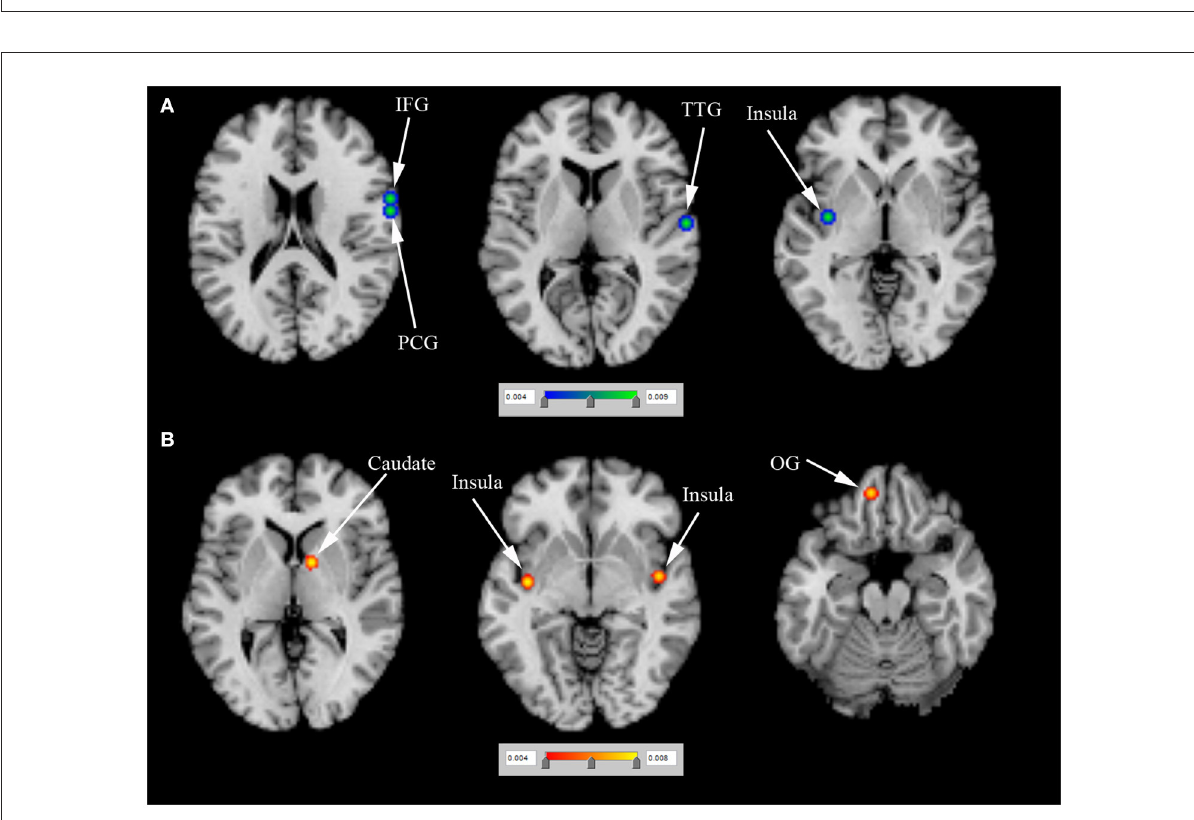
FIGURE3 (A) Reduced resting-state brain activation (in blue) and (B) increased resting-state brain activation (in red) in PD-ICD patients, compared to PD-no ICD. ICD, impulse control disorder; IFG, inferior frontal gyrus; OG, orbital gyrus; PCG, precentral gyrus; PD, Parkinson’s disease; TTG, transverse temporal